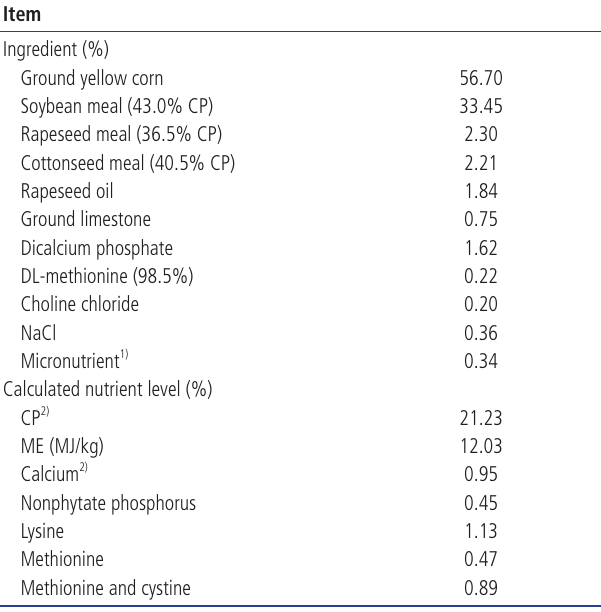
Table 1. Composition and nutrient levels of the basal diets (as-fed basis)